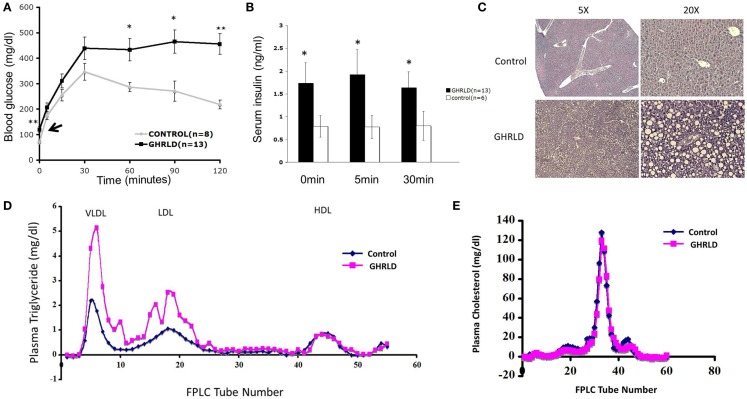
Aged GHRLD mice developed glucose intolerance, hyperlipidemia, and hepatic steatosis. (A) Intraperitoneal glucose tolerance test of 44–50 weeks old GHRLD mice (n = 13) and age-matched controls (n = 8). Arrow indicates the blood glucose levels of GHRLD mice after overnight fasting (16 h). Data are presented as mean ± SEM. *p < 0.05; **p < 0.01. (B) Serum insulin levels in GHRLD (filled bars, n = 13), or control (open bars, n = 6) mice. Sera were collected from either after overnight fasting (0 min), 5- or 60-min after i.p. injection of a bolus of 2 g/kg of d-glucose. Data are presented as mean ± SEM. *p < 0.05. (C) Representative histological sections (H&E) of liver samples harvested from 44 to 50 weeks old GHRLD (lower panels) and age-matched controls mice (upper panels). Left panels, 5× objective lens magnification; right panels, 20×. (D,E) Effect of liver-specific GHR deletion on lipoprotein metabolism. Aliquots of plasma (250 μl) pooled from individual mice in GHRLD mice (n = 6) and control mice (n = 6) subjected to gel filtration chromatography, followed by the determination of TG (D) and cholesterol (E) concentrations in fractions. The peak fractions of 3–10, 14–23, and 40–50 in (D) represent VLDL, LDL, and HDL, respectively.